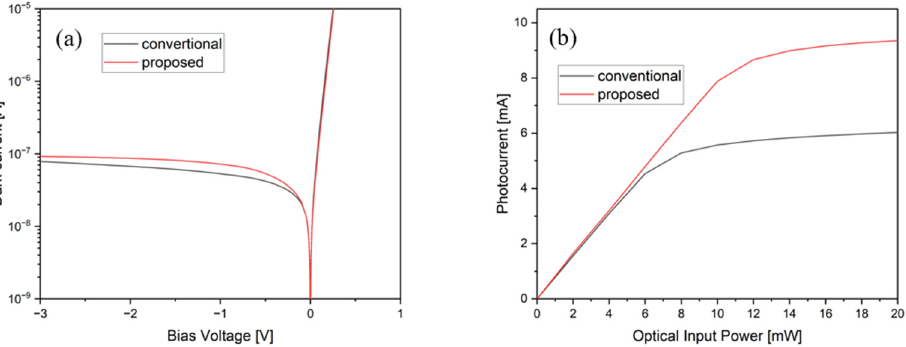
Figure 2. ( a ) The simulated dark current of conventional and proposed detectors. ( b ) The simulated photocurrent as a function of 1550 nm TE-polarized input power to the conventional and proposed detectors, under − 1 V bias voltage.